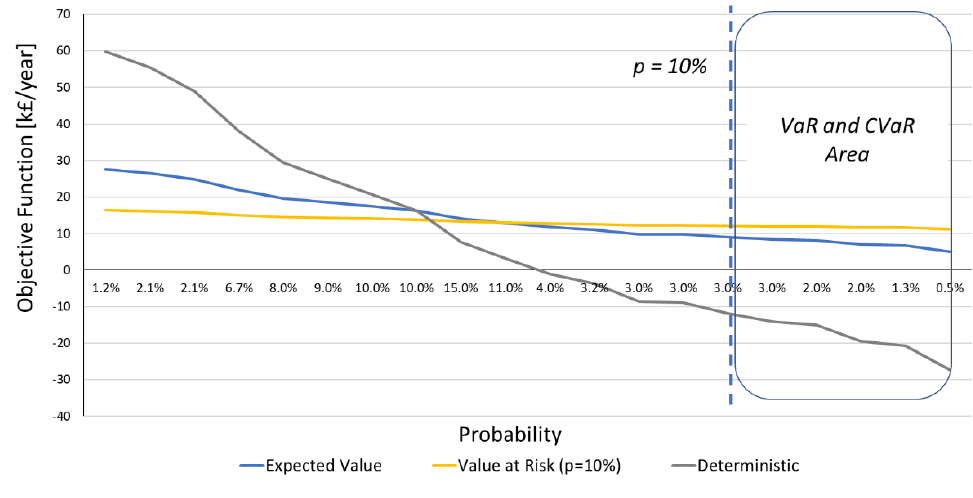
Figure 2. Consumer benefits from DG. Table 2. Risk indicators (k£/year) using different approaches.